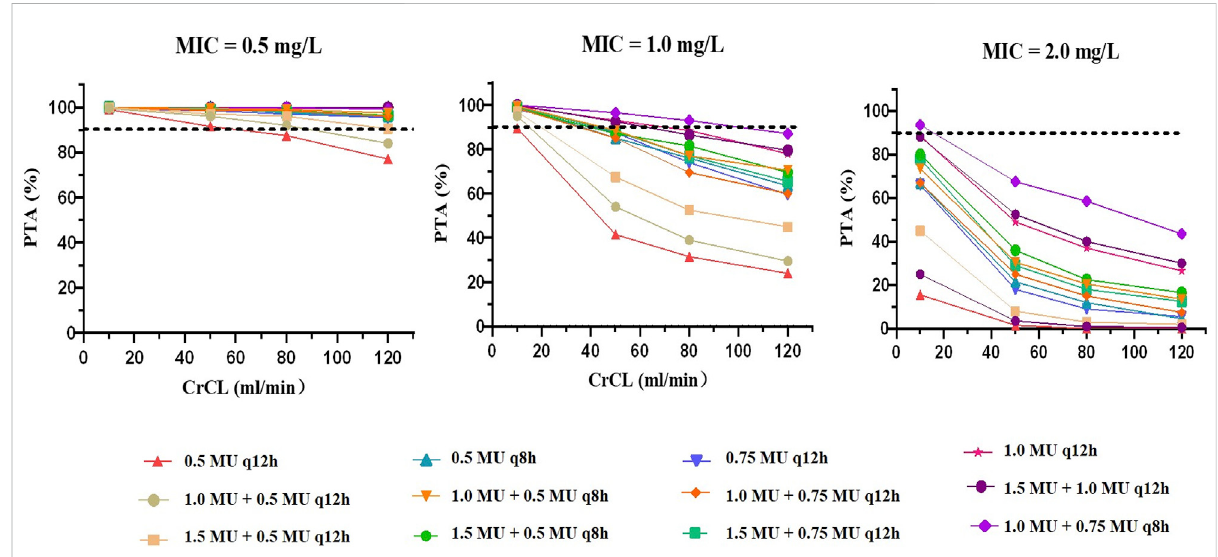
FIGURE 4 PTAsfordosingregimensperformedbasedonthe fi nalPPKmodelonDay3.ThedottedlinerepresentsthetargetPTAof90%.AtoCshowMICs of 0.5 mg/L, 1.0 mg/L and 2.0 mg/L, respectively.